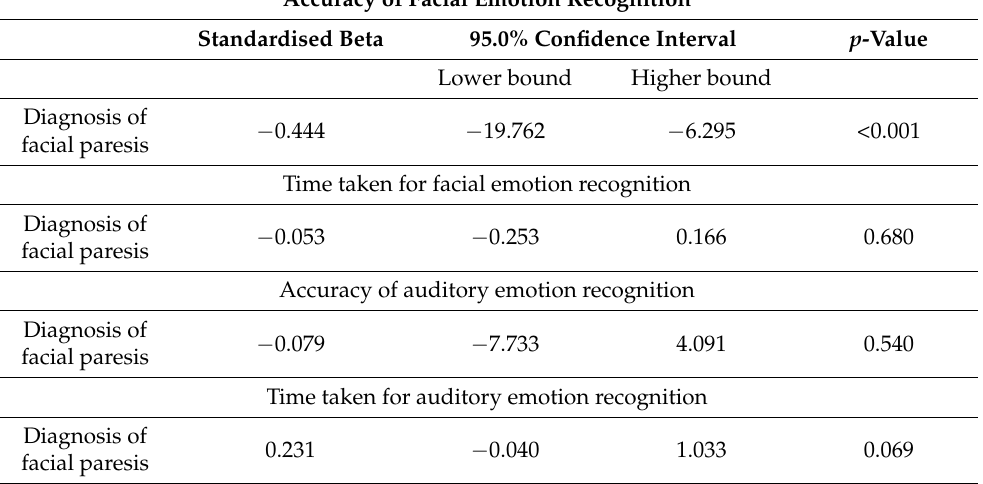
Table A7. Univariate regression